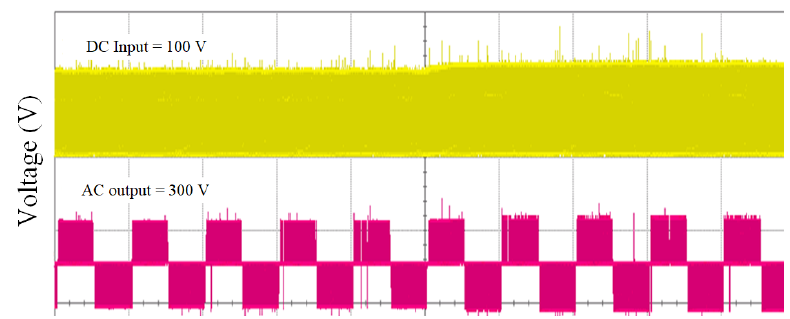
Figure 12. Voltage waveform of proposed converter-inverter